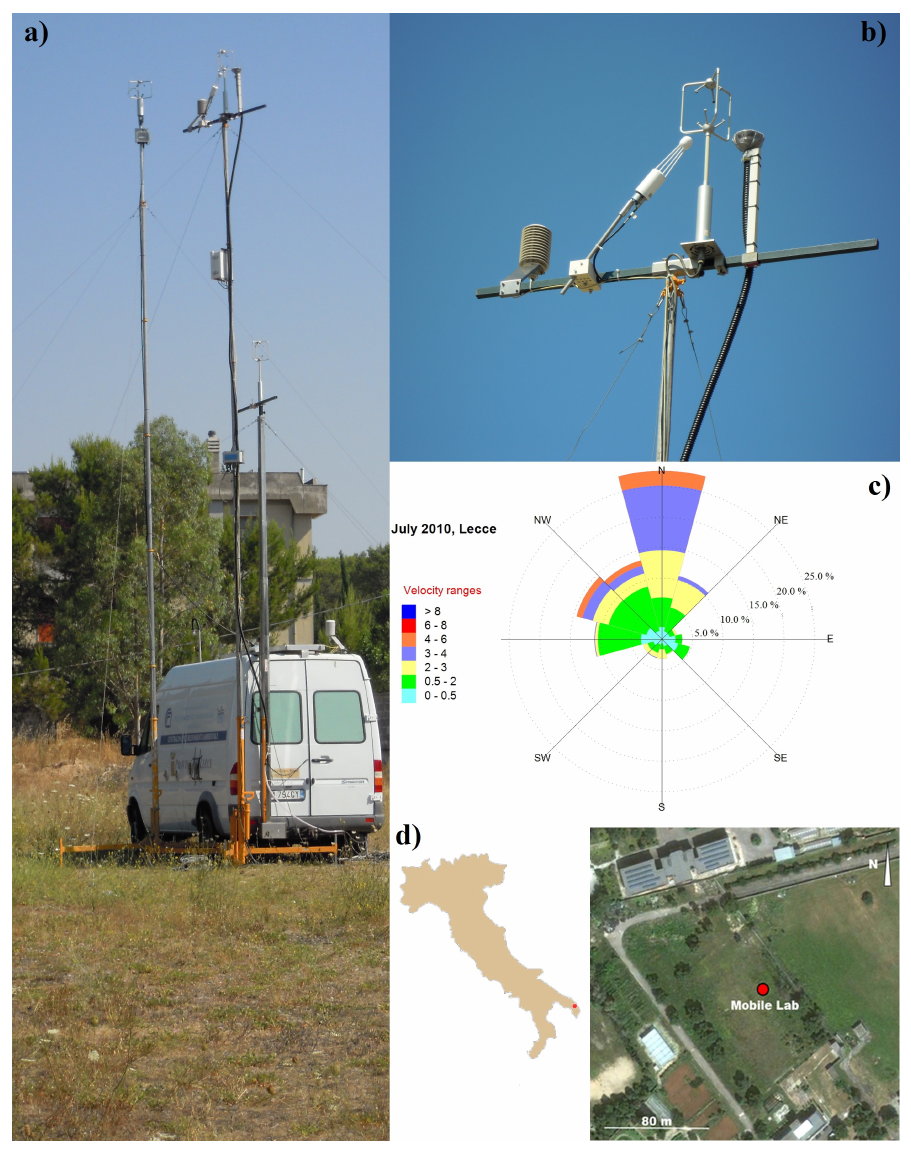
Figure 1. Experimental setup inside the university campus: ( a ) mobile laboratory; ( b ) upper part of the mast hosting the eddy-covariance (EC) system; ( c ) wind rose relative to all of the measurement period; ( d ) satellite image showing the position of the measurement